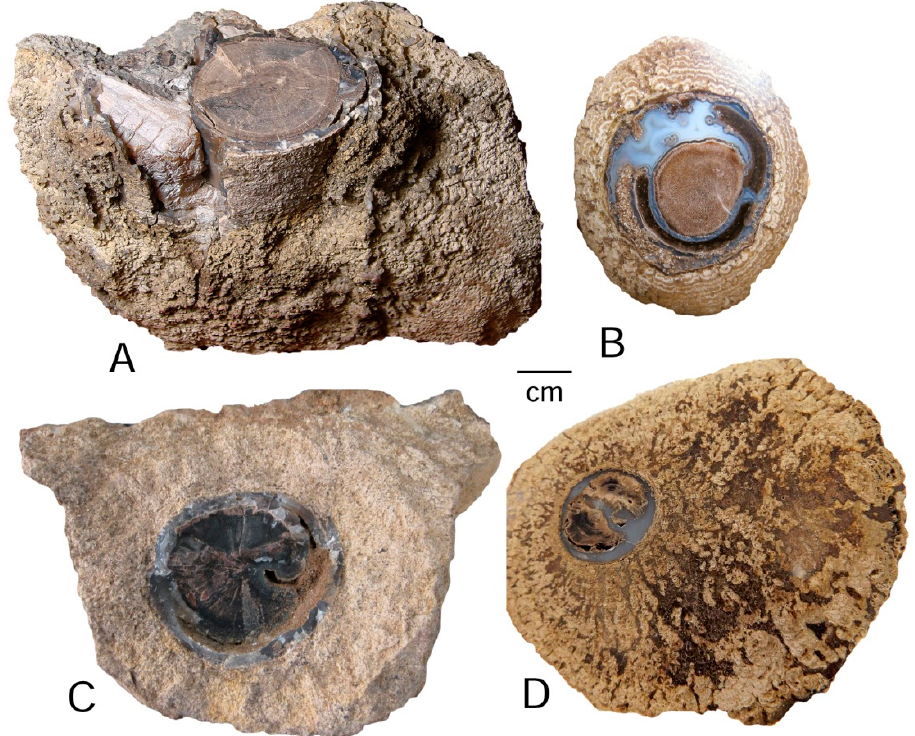
Figure 6. Freshly-excavated Blue Forest specimens. ( A ) Log coated with silicified biogenic calcareous material. ( B ) Limb surrounded by a stromatolitic layer. ( C ) Slender limb, fractured during excavation. Photos by Mike Viney, 2018.